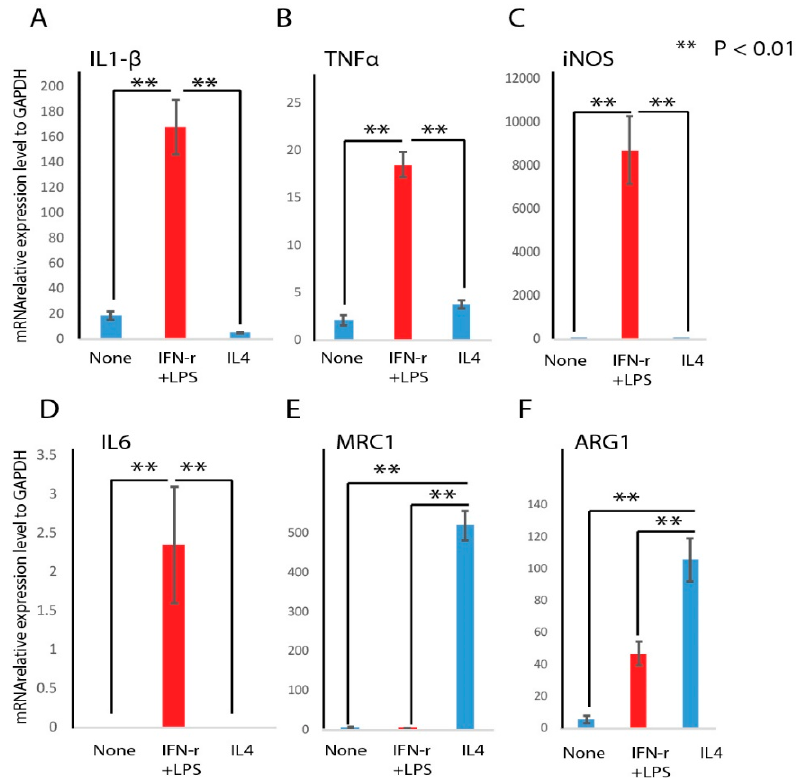
Figure 2. Pro-inflammatory (M1) and regenerative or pro-remodeling (M2) marker mRNA abundance analysis after induction. RAW macrophages were treated with LPS and IFN-r or IL4 for 24 h to induce the M1 or M2 phenotype, respectively. M1 marker genes IL1-beta ( A ), TNFa ( B ), iNOS ( C ), and IL6 ( D ), or M2 marker genes MRC1 ( E ) and ARG1 ( F ) were determined by real-time PCR ( n = 3, mean + SD, ** p < 0.01).